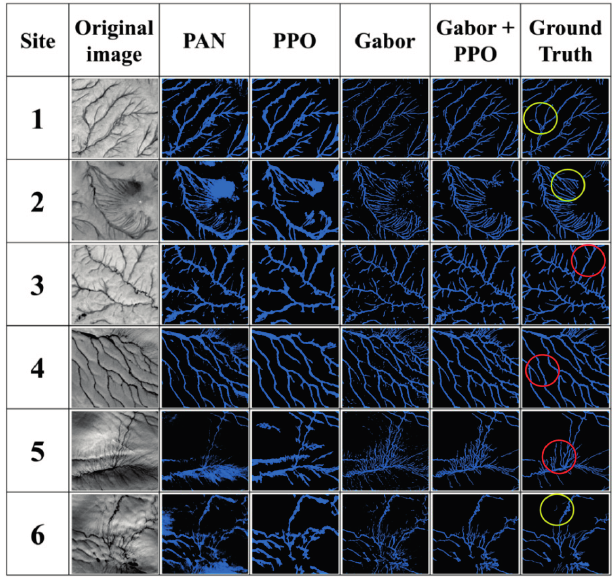
Figure 11. River detection results for Sites 1–3 in the Yukon image (rows 1–3) and Sites 4–6 in the Greenland Ice Sheet image (rows 4–6). The first column shows the site number; the second shows the original Landsat 8 OLI panchromatic images; the third to sixth columns show the river detection results when one global threshold (mean + 0.5 std) is applied to the original panchromatic image, the PPO-processed image, the Gabor-filtered image, and the Gabor + PPO processed (the proposed method) image, respectively; and the last column shows the corresponding ground-truth river maps. The red circles indicate the places where pixels were erroneously detected as rivers by the proposed method, while the yellow circles indicate the places where actual rivers were not correctly